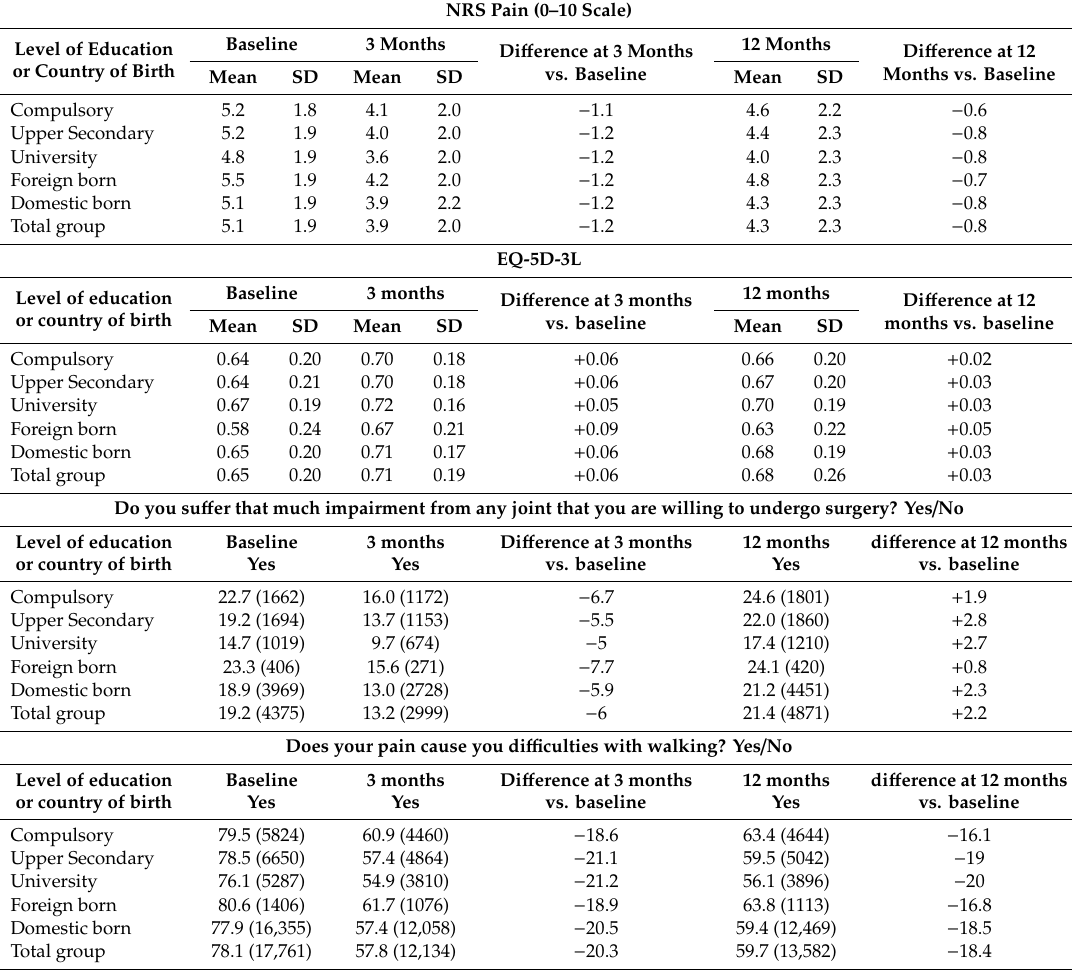
Table 2. Descriptive results for outcome variables related to Pain, HRQoL, willingness to undergo joint surgery and mobility ( n =